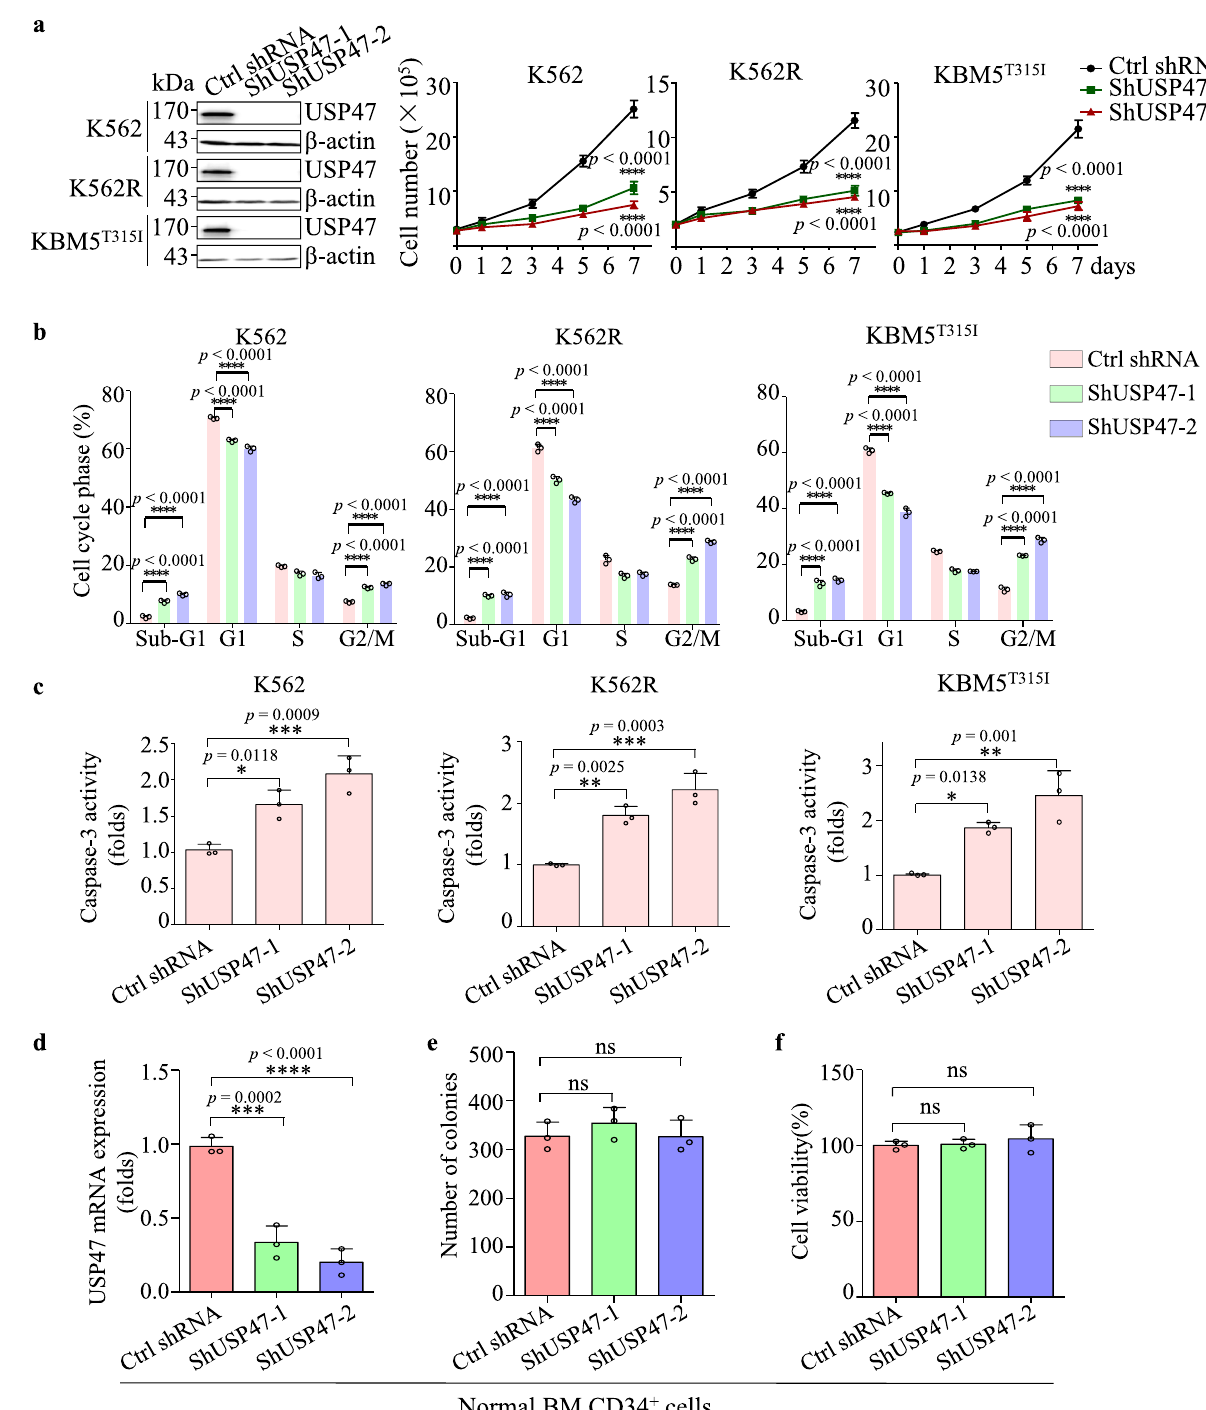
Fig. 2 Knockdown of USP47 inhibits the proliferation of CML cells. a USP47 was silenced in K562, K562R, and KBM5 T315I cells using a retroviral transduction system as described in Methods. Viable cells were counted in the transfected cell lines at different times ( n = 3 biologically independent samples per group). b Cell cycle was measured in the transfected cell lines on day 3 ( n = 3 biologically independent samples per group). c Caspase-3 activity was measured after 3 days of retroviral transfection ( n = 3 biologically independent samples per group). d Knockdown ef fi ciency of USP47 in normal human BM CD34 + cells was determined by real-time PCR ( n = 3 biologically independent samples per group). e , f The number of colonies ( e ) and cell viability ( f ) were measured. Data are mean ± s.d. p- values were analyzed by two-way analysis of variance (ANOVA; a , b ) or one-way ANOVA ( c – f ). * p < 0.05, ** p < 0.01; *** p < 0.001; **** p < 0.0001; ns, no signi fi cant. Source data are provided as a Source Data fi